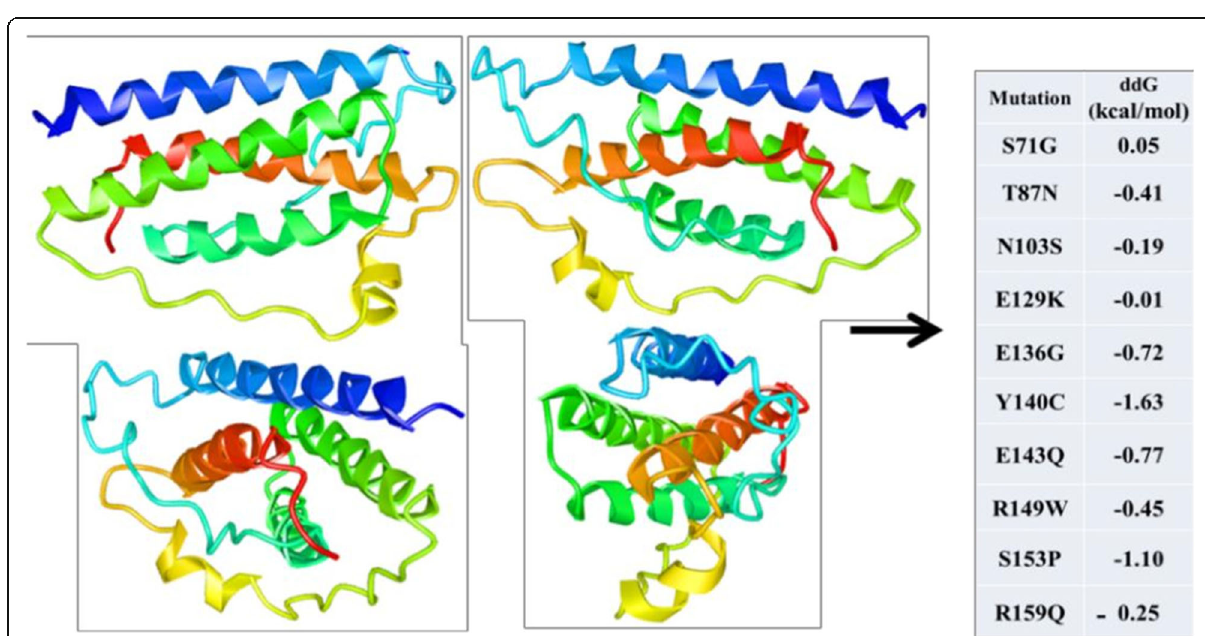
Fig. 6 The predicted 3D tertiary structure of the mature river buffalo leptin peptide from several views and the effect of the detected mutations on its